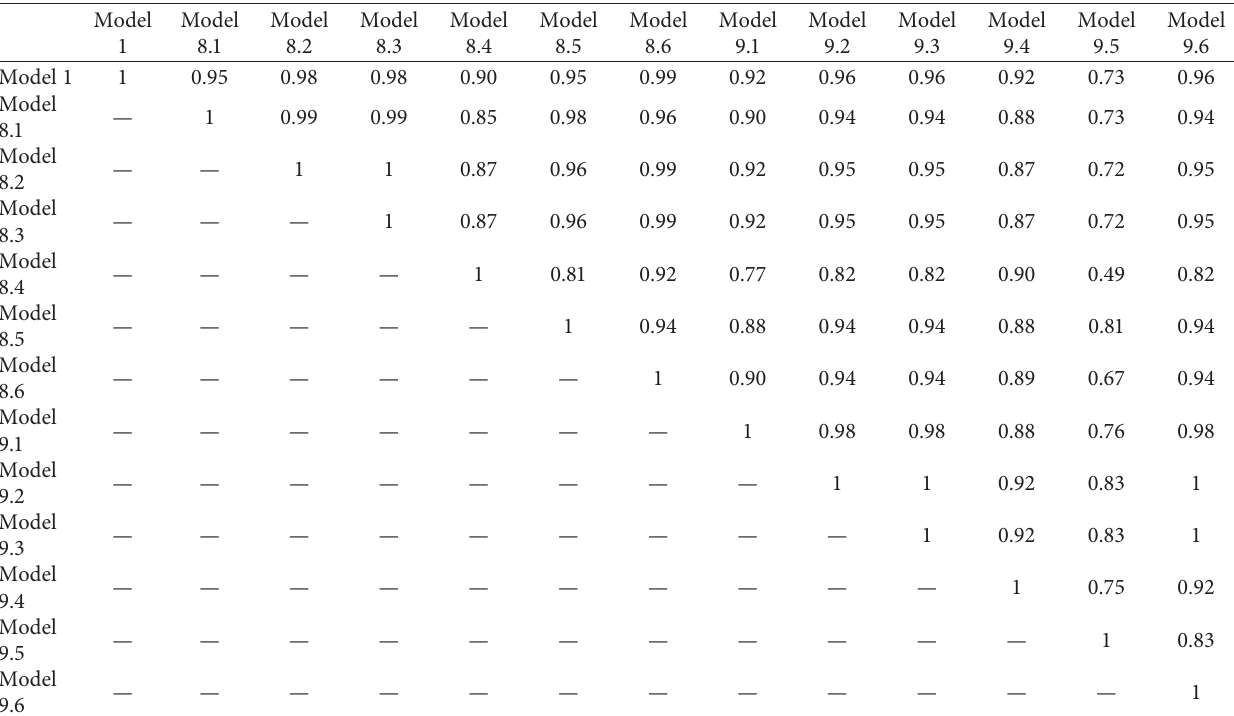
Table 23: Correlation of the ranks in the models 1, 8, and